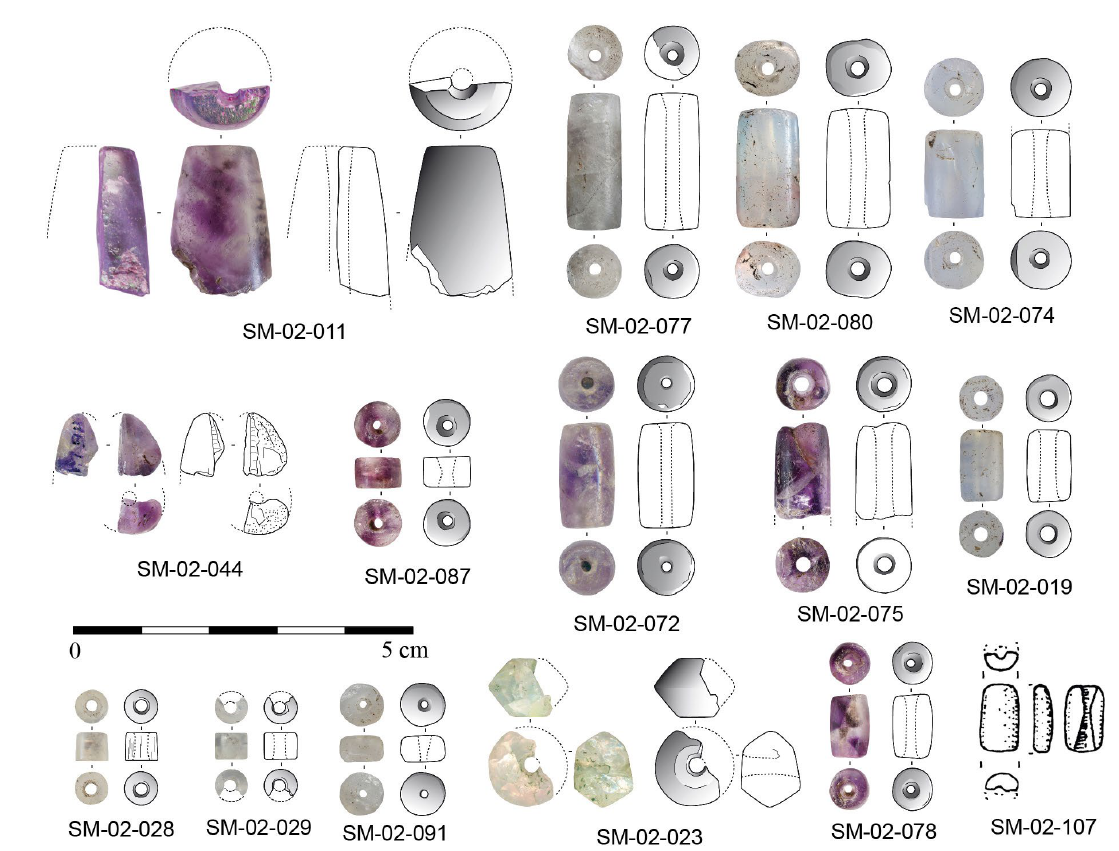
Figure 4: hotographs and drawings of the beads and manufacturing debris from the site of Hope Estate (SM-02), Saint-Martin.